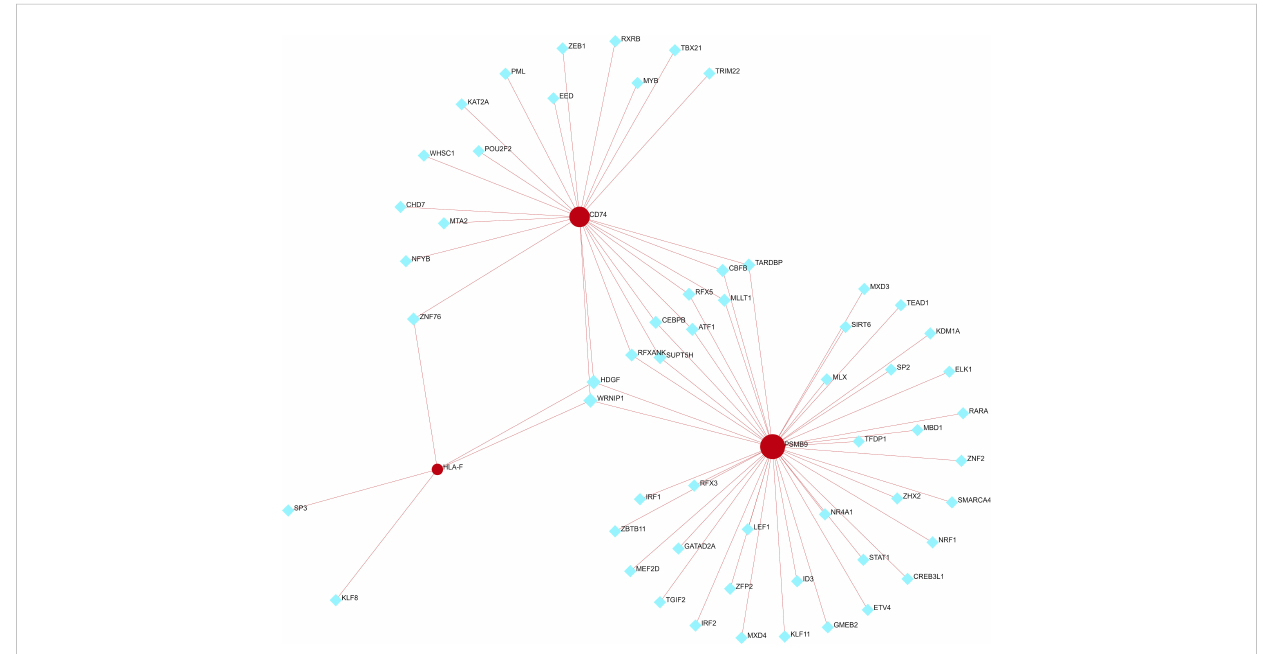
FIGURE 8 TF-shared hub gene regulatory network. The red circle represents a shared hub gene, while the blue diamond represents transcription factors. TFs, transcription